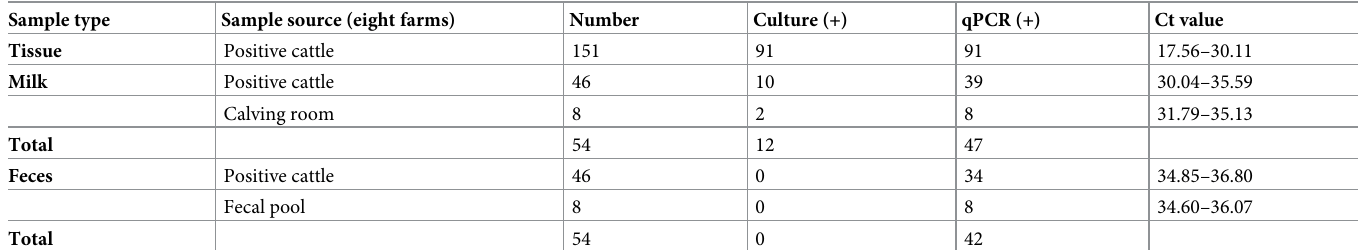
Table 2. The results of tissue, milk and feces samples by culture and qPCR. Sample